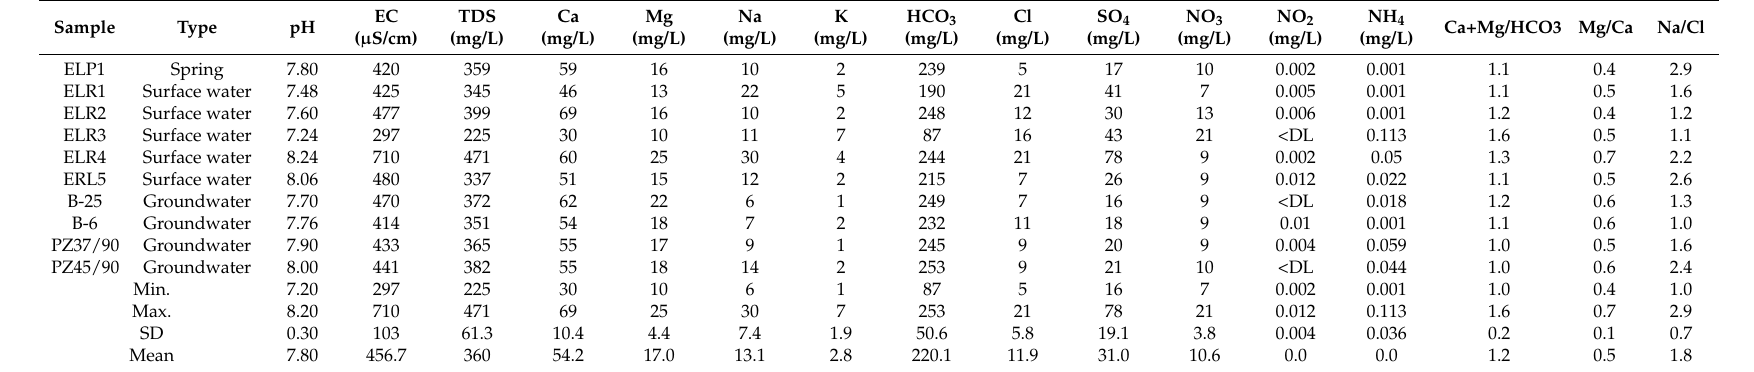
Table 2. Results and statistical analysis of the hydrochemical data. (DL: Limit of